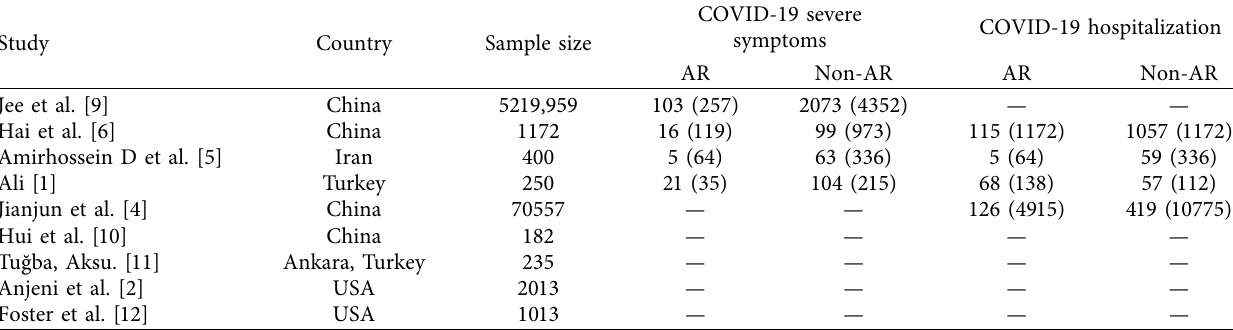
Table 1: Summary of findings table.